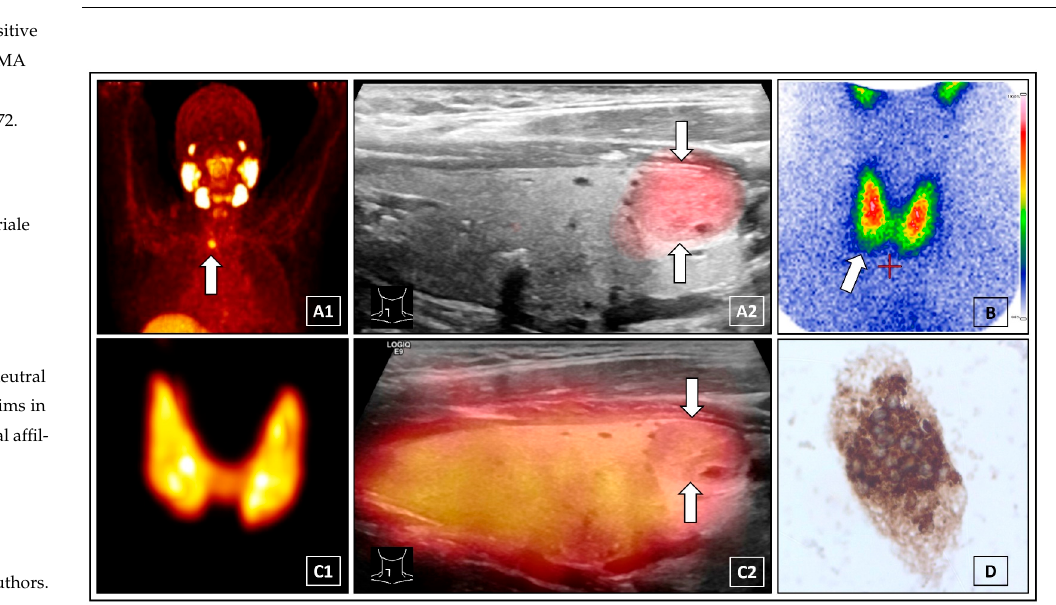
Siemens, Erlangen, Germany) were transferred to the LOGIQ E9 ultrasound device (GE Healthcare, Milwaukee, WI, USA). According to anatomical landmarks on CT, e.g., spine, larynx, trachea, the PET/CT images were manually superimposed and aligned to the ultrasound images using a mag- netic field based navigation system and the VNAV software (GE Healthcare) [6]. For 124 Iodine PET/US fusion imaging, a single bed position (10 min scan time) low-activity (1 MBq 124 Iodine) cer- vical PET/CT (low-dose CT scan) was performed. The effective whole body dose for the patient was ~6.8 mSv [7]. The “FUSION iENA” study (obtained by independend ratings of 106 nuclear medicine physicians) revealed that 124 Iodine PET/US fusion imaging significantly improves the accuracy and the confidence of the functional assessement of thyroid nodules as well as influences the suggested treatment for patients with ambiguous findings on conventional diagnostics [8]. Fine-needle cytol- ogy was performed using an magnet-based ultrasound needle-guidance system to ensure that the cells were acquired from the PSMA-positive thyroid nodule [9]. The cytopathological investigation showed a benign thyroid nodule according to Bethesda category II with positive thyroglobulin staining ( D ) [10]. Finally, thyroid cancer as well as an intra-thyroid prostate cancer metastasis could be ruled out. This interesting image demonstrates the first application of PET/US fusion imaging in a PSMA-positive thyroid nodule and demonstrates the diagnostic potential of combined modern multimodal methods in the field of nuclear medicine.